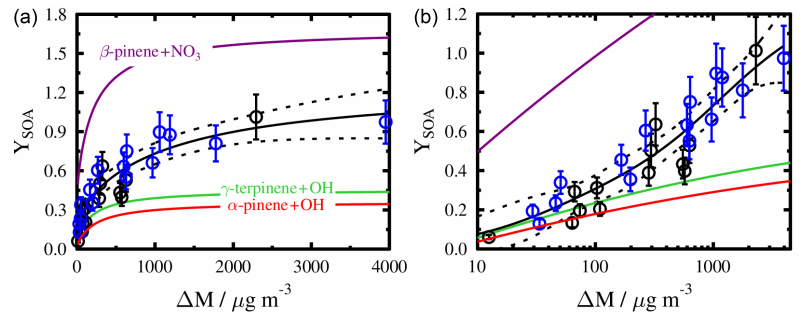
Figure 2. Change in aerosol mass concentration ( (cid:49)M ) and wall-loss-corrected SOA yields ( Y SOA ) from the NO 3 oxidation of γ -terpinene in unseeded (black circles) and (NH 4 ) 2 SO 4 -seeded experiments (blue circles). The data were fitted to a two-product absorptive partitioning model (black curve) and the dashed curves represent the 95% confidence intervals of the fitting function. For comparison, the mass-dependent yield curves of α -pinene and γ -terpinene in the presence of OH are shown in the red and green curves, respectively, and β -pinene + NO 3 in purple (Griffin et al., 1999; Lee et al., 2006). For clarity, (b) shows (a) data on a log